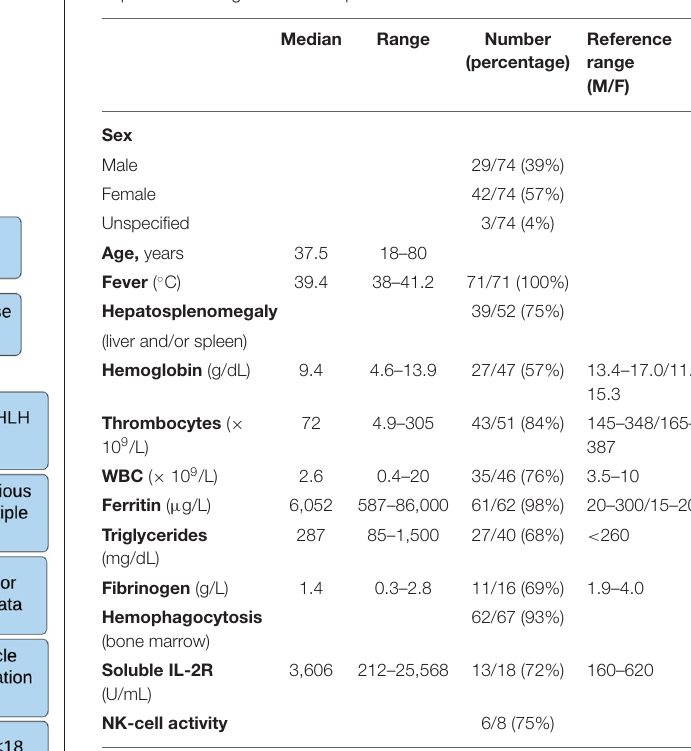
TABLE 3 | An overview of the clinical findings upon arrival/time of diagnosis described in literature, including confirmed diagnostic findings among the number of patients investigated for each